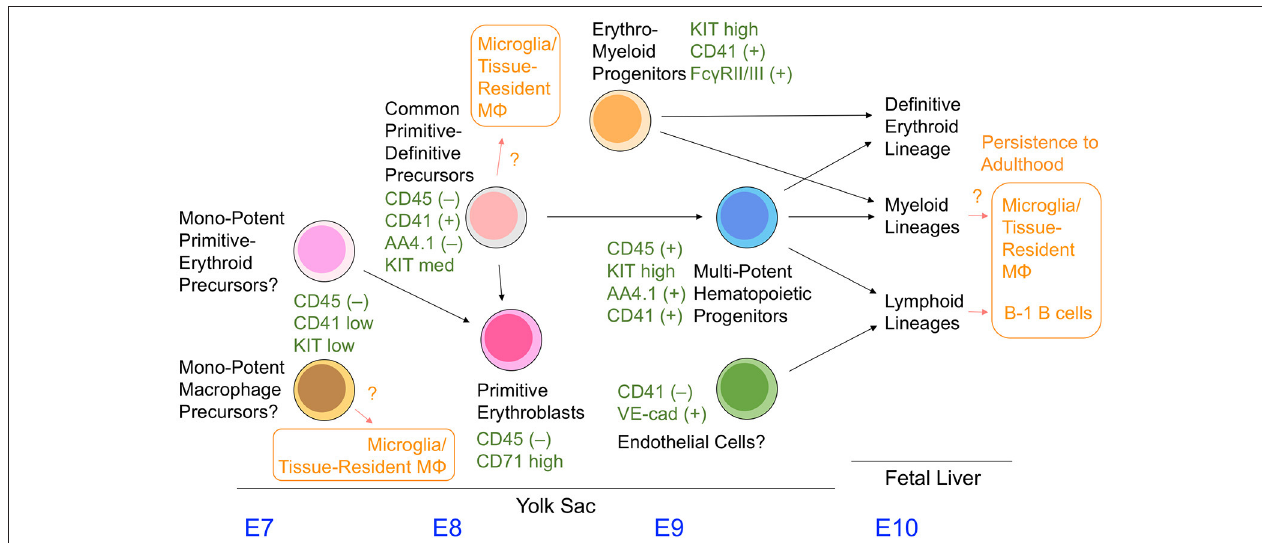
FIGURE 3 | A model showing our current understanding of yolk sac hematopoiesis.